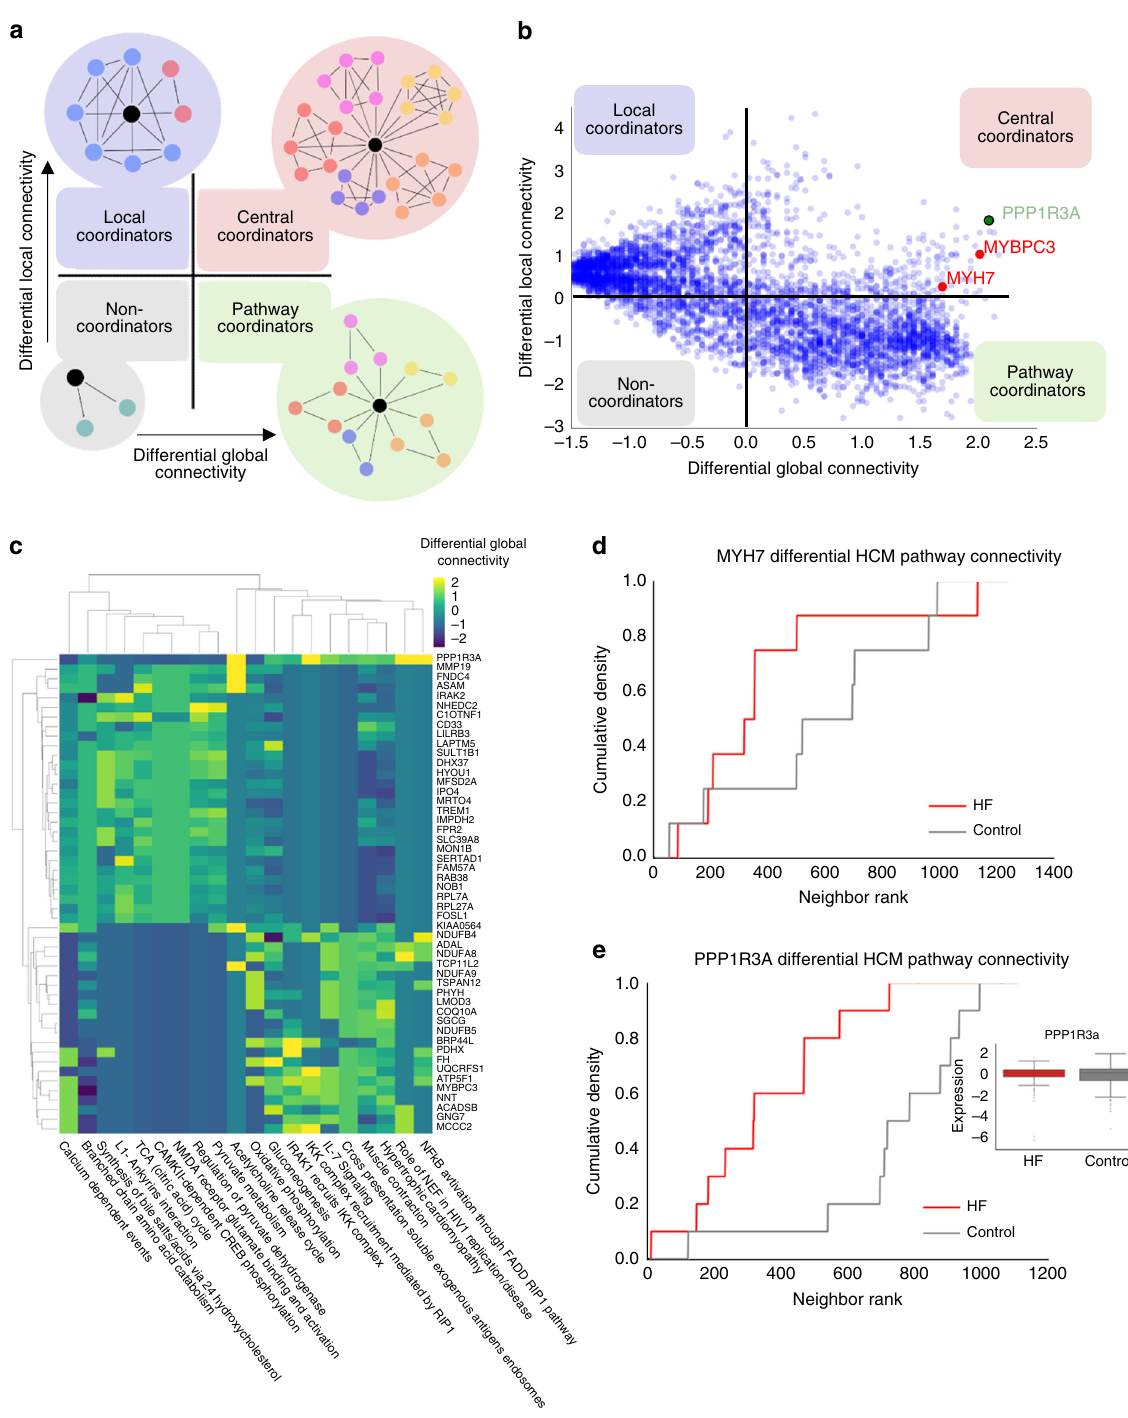
Fig. 3 Gene prioritization through network topology. a Diagrammatic representation of roles of local and global connectivity in de fi ning each gene ’ s coordinator status. Local connectivity (LC) is the per-gene change in coexpression edges in the HF vs. control network. Global connectivity (GC) represents the enrichment of HF-relevant pathways in a gene ’ s neighborhood between HF and control networks (see Methods). b Change in local and global connectivity for all genes between control and HF networks identi fi ed PPP1R3A (green font) as a central coordinator in HF, indicating its increased association with HF-relevant pathways as well as coexpression relationships in the HF vs. control networks. c Gene-pathway (rows-columns) differential connectivity matrix for genes ranked highest for global network connectivity that is differentially increased between non-heart-failure and heart- failure conditions. Differential connectivity is measured by the KS statistic between the distribution of ranks for pathway genes in HF and non-heart-failure conditions. In particular, metabolism, HF and cardiomyopathy pathways (yellow indicates an increase in connectivity to the given pathway (columns) in HF compared to control samples). d Difference in cumulative membership distributions for the KEGG Hypertrophic Cardiomyopathy (HCM) pathway for the myosin gene MYH7 which is known to be involved in HCM. e Difference for HCM pathway enrichment in the protein phosphatase 1 regulatory subunit PPP1R3A is more dramatic than for MYH7 . Inset: PPP1R3A transcriptional expression in HF and Control cohorts is unchanged